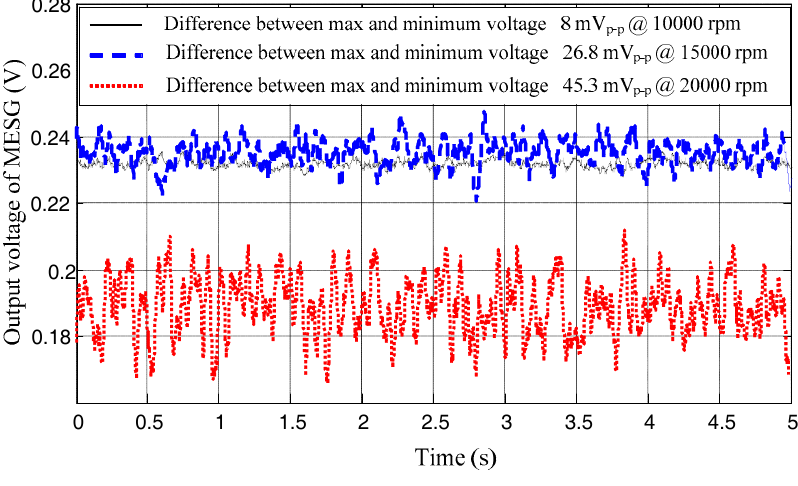
Figure 6. Static gyroscope outputs at different spin rates.